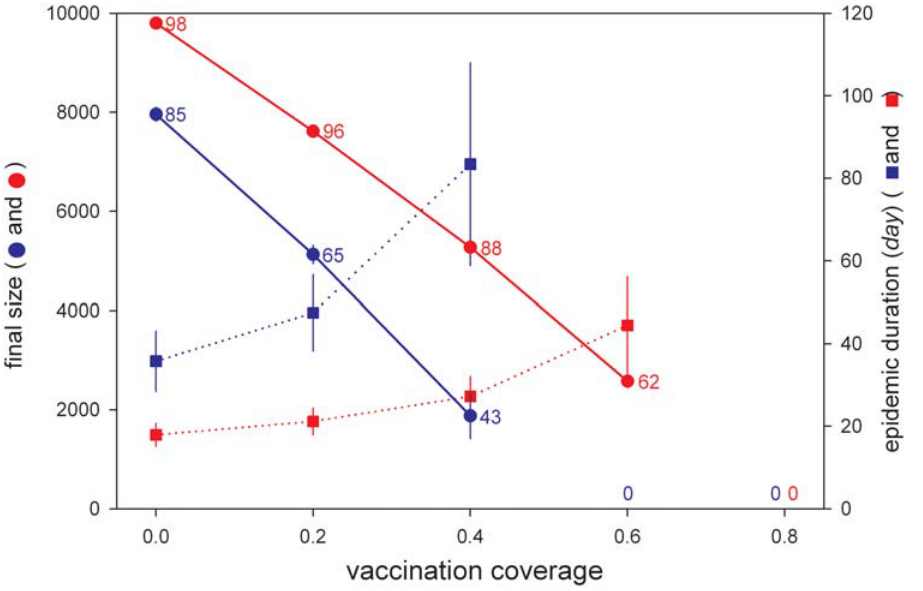
Figure 5. The effect of preventive vaccination as a function of vaccination coverage. Circles refer to the final size of major outbreaks (error bars: 6 2SD) and squares indicate the duration of major outbreaks (error bars: 6 2SD). Blue and red lines represent the low and high transmissibility scenarios, respectively (cf. Figure 4). 100 simulations are performed for each parameter constellation. Numbers near the circles refer to the number of simulations that yield a major outbreak. Major outbreaks are operationally defined as those outbreaks in which at least 50 birds are